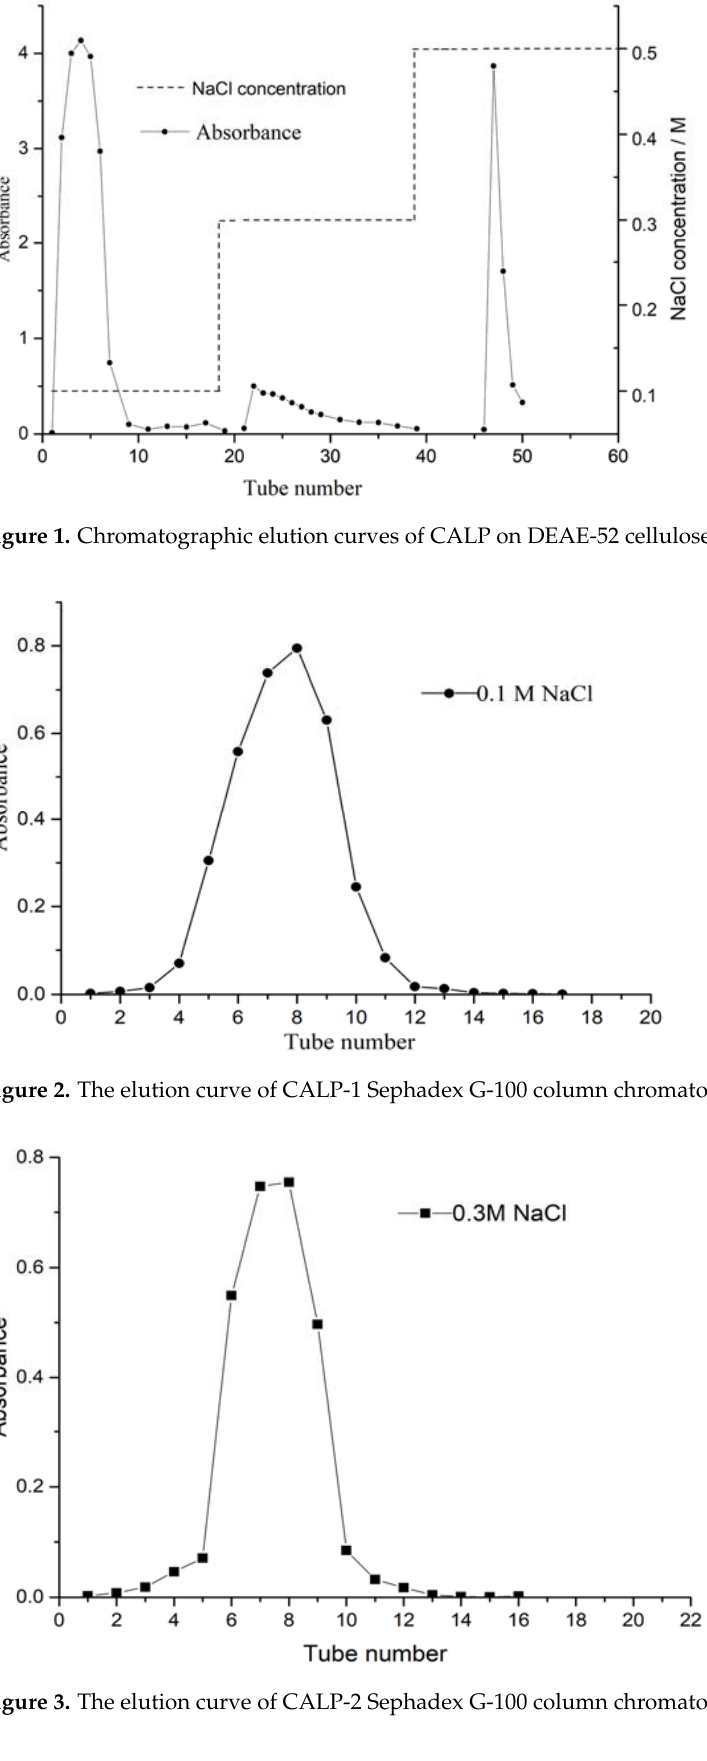
Figure 3. The elution curve of CALP ‐ 2 Sephadex G ‐ 100 column chromatography. Both CALP ‐ 1 and CALP ‐ 2 were single symmetrical peaks with the highest absorb ‐ ance on the 8th tube. The fractions named CALP ‐ 1 and CALP ‐ 2 were collected from tubes 4–11 with a yield of 45.21% and 35.36% from the crude CALP, respectively. 2.2. Characteristic of CALP ‐ 1 and CALP ‐ 2 The homogeneity and molecular weight of CALP ‐ 1 and CALP ‐ 2 were detected by the HPGPC method, and the results are shown in Figures 4 and 5. Figure 4. HPGPC profiles of CALP ‐ 1.